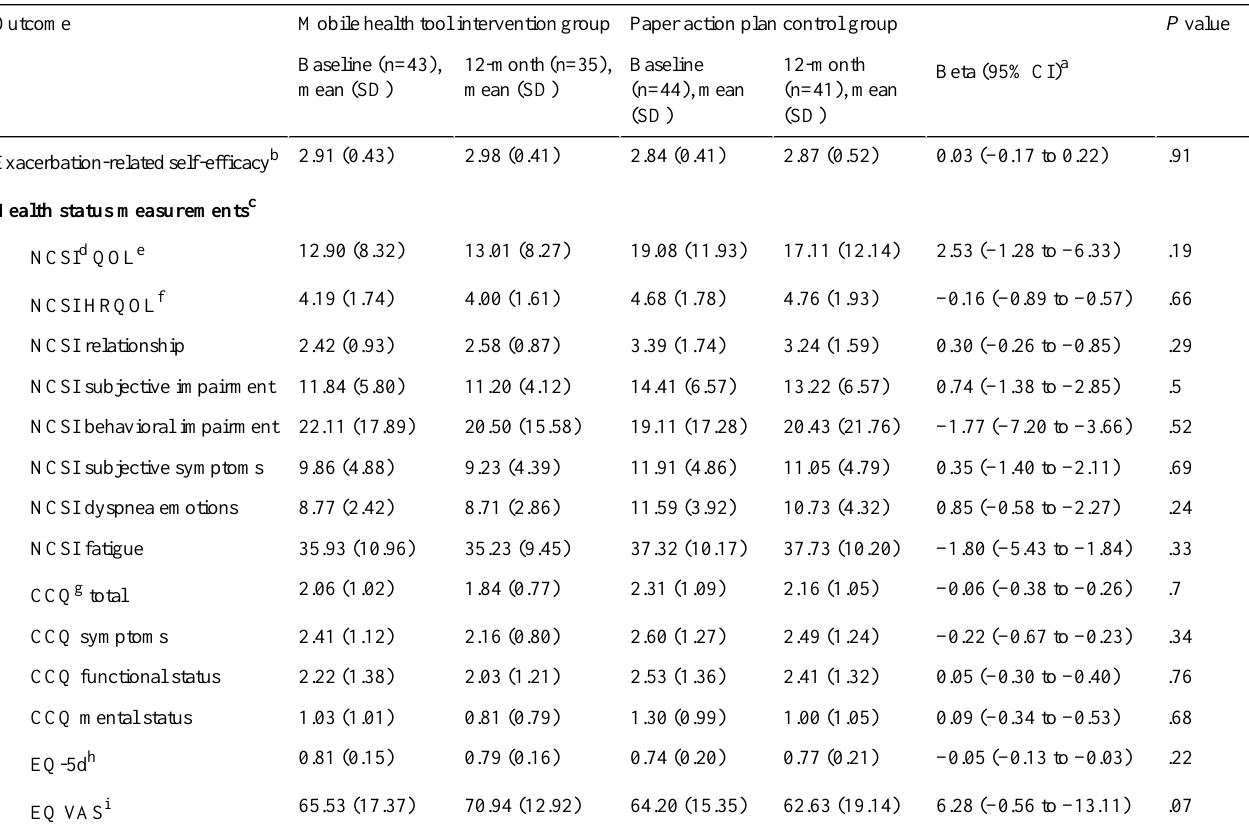
Table 5. Baseline and follow-up scores of exacerbation-related self-efficacy and measures of health status.